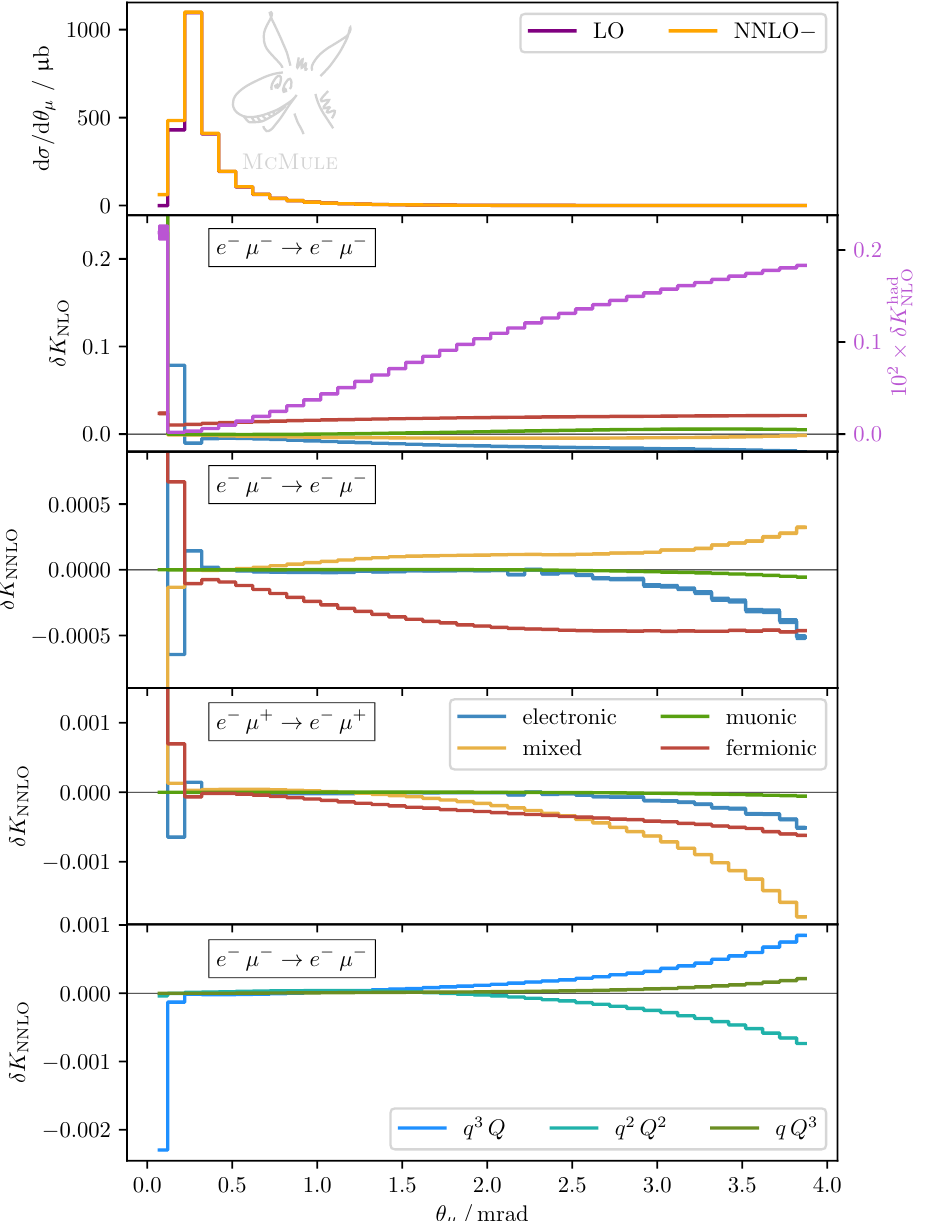
Figure 5 . From top to bottom: (i) differential cross section w.r.t. θ µ for S1 ’ at LO (violet), and NNLO (orange) for negative muons; (ii) NLO K factor for negative muons (positive muons have a sign flip for the mixed photonic correction); (iii) NNLO K factor for negative muons; (iv) NNLO K factor for positive muons; (v) NNLO K factor for disentangled mixed photonic corrections, for negative muons. In panels (ii)–(iv) the correction is split into photonic, i.e. electronic, mixed and muonic, and fermionic, including leptonic and hadronic. The hadronic correction at NLO corresponds to the signal of the experiment and is shown separately in purple in panel